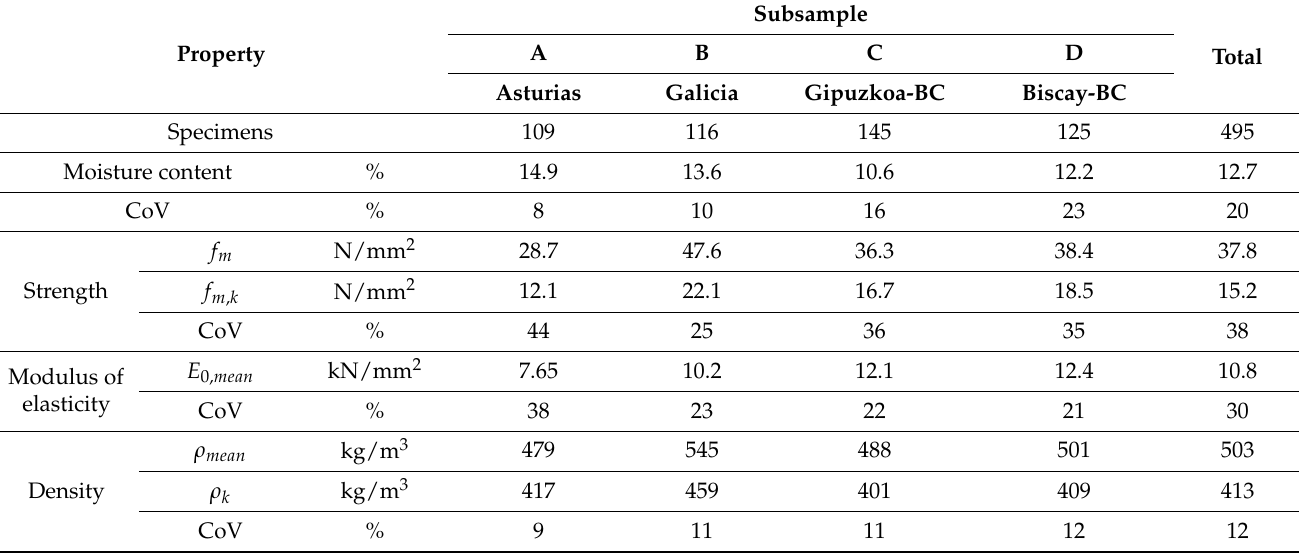
Table 3. Characteristic values of the mechanical and physical properties of radiata